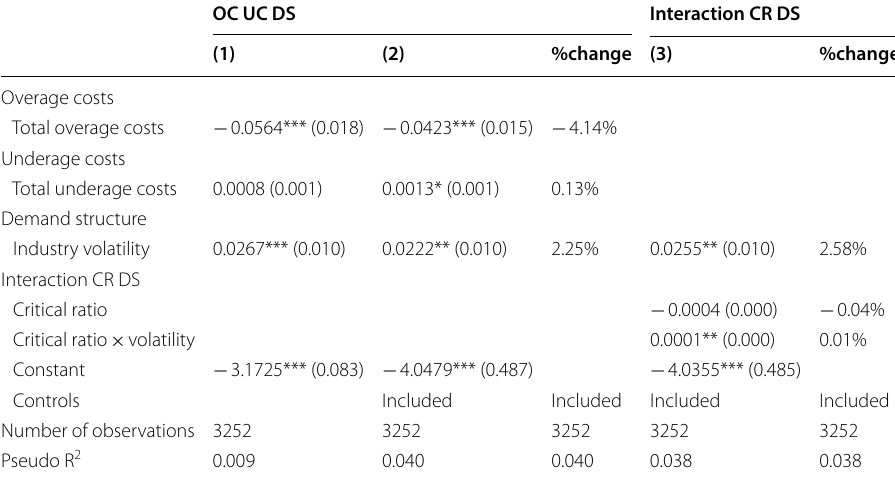
Table 3 Main determinants of the training intensity (optimal inventory level). Source BIBB CBS